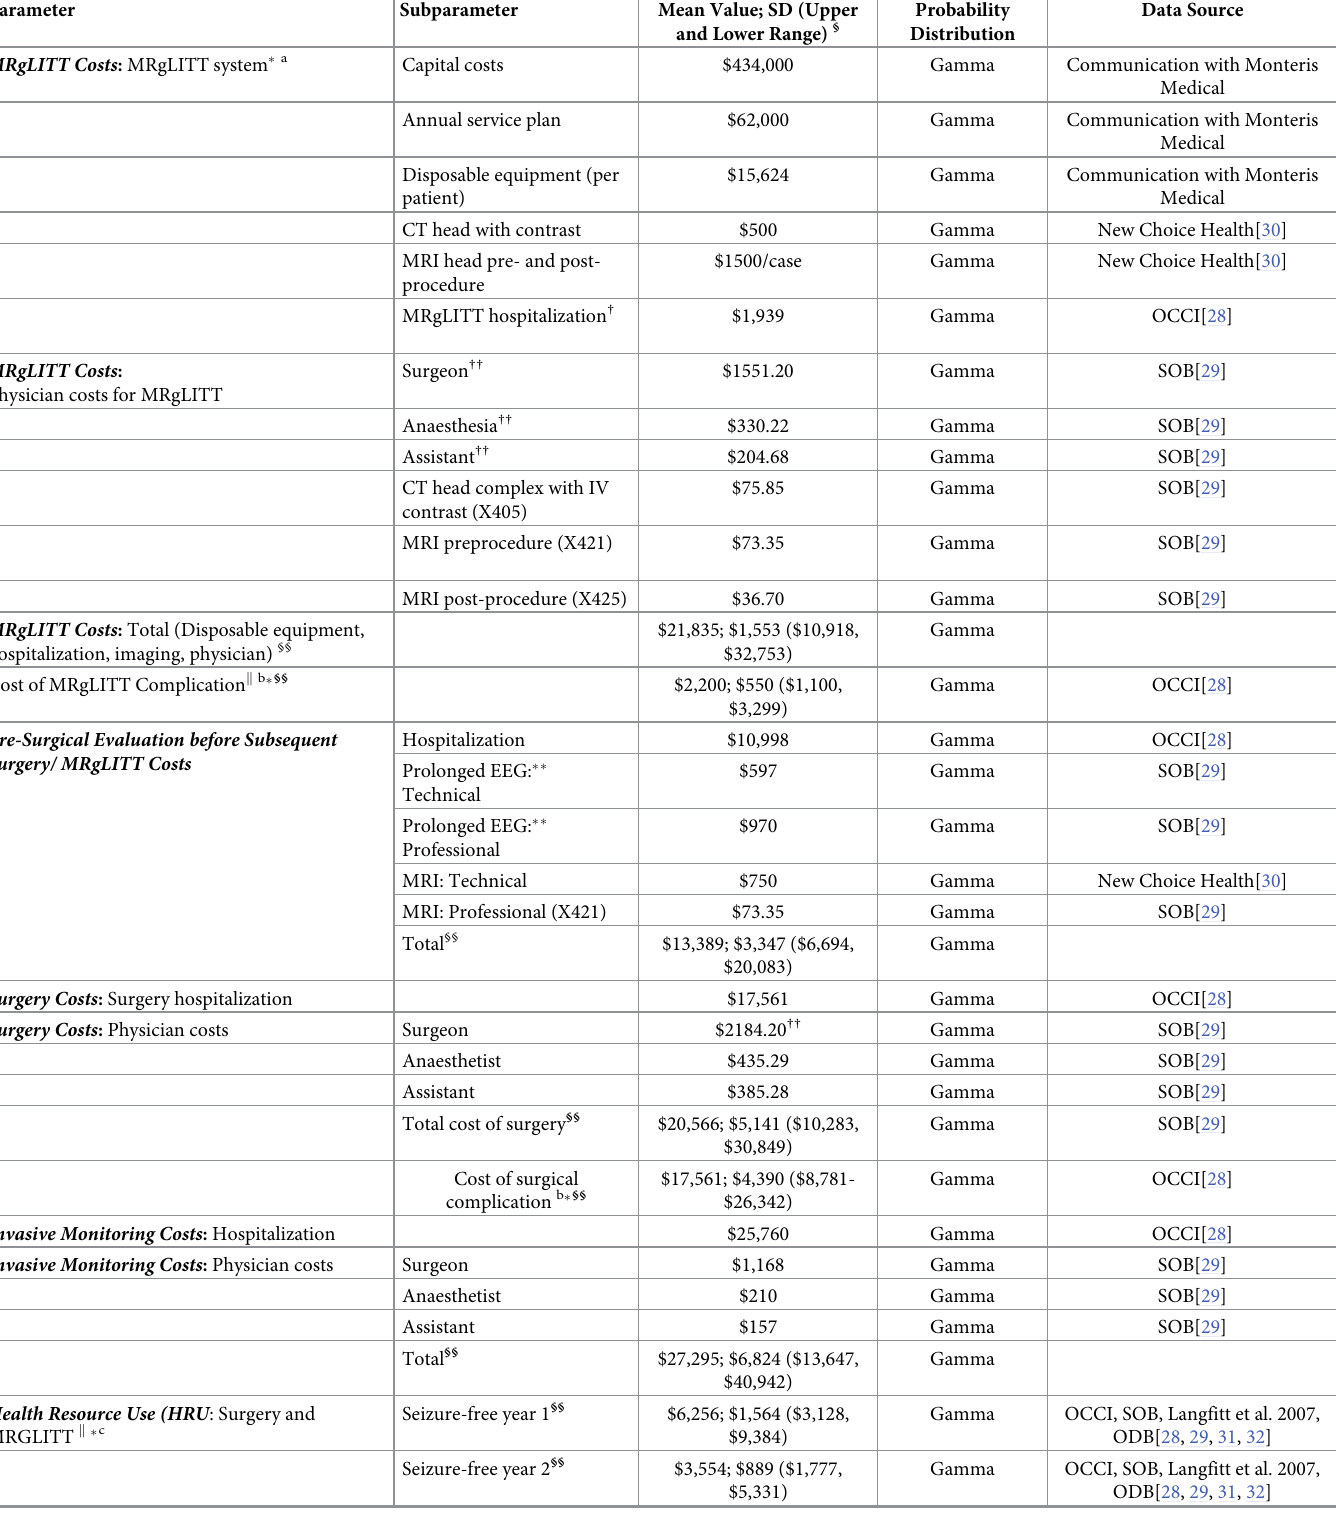
Table 2. Cost parameters for